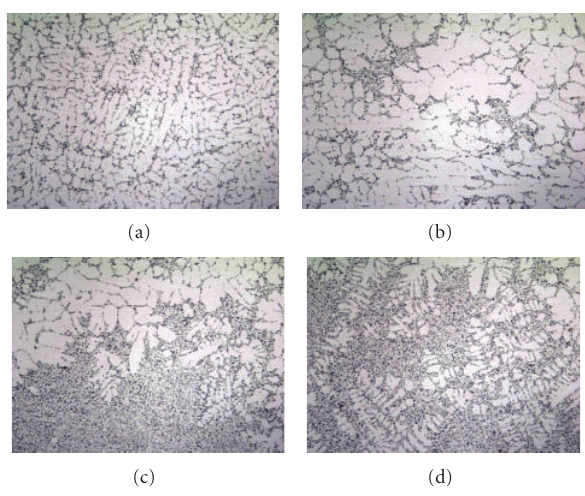
Figure 17: Microstructure of each position.